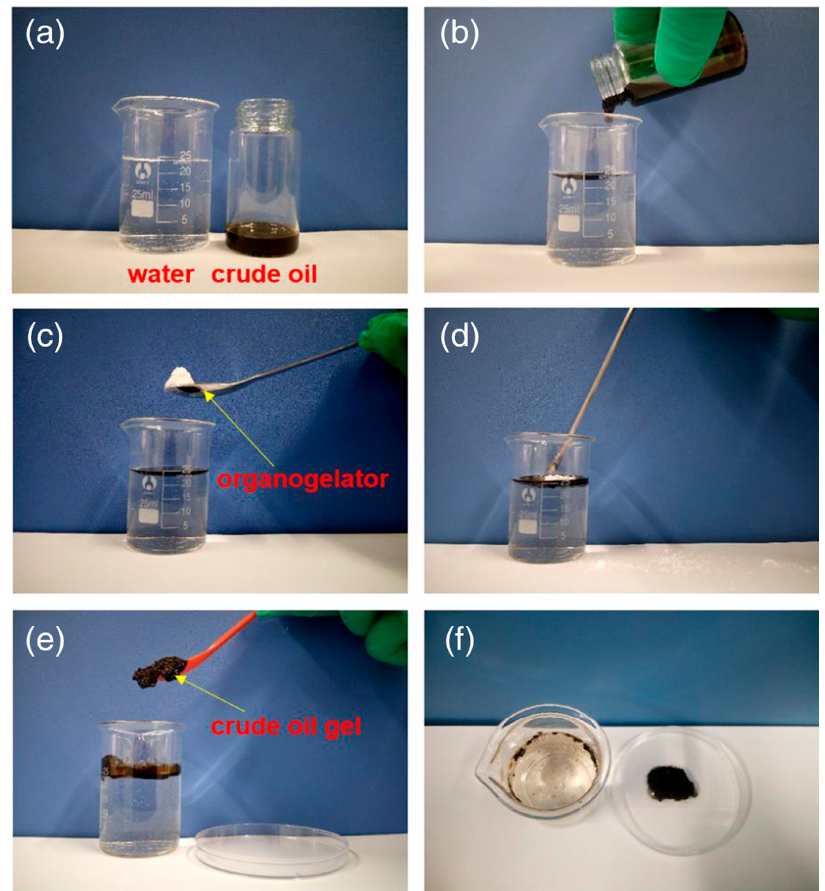
Figure 7. Removal of crude oil from oil/water mixtures using PSOG in the form of dry powder: ( a ) Single-phase water and crude oil; ( b ) Adding crude oil to the water phase; ( c ) Putting the PSOG powder on the crude oil layer; ( d ) Dispersing the PSOG powder into crude oil by stirring; ( e ) Removing the solidified oil using a spoon; ( f ) The water phase after removing crude oil and the formed gel [58].